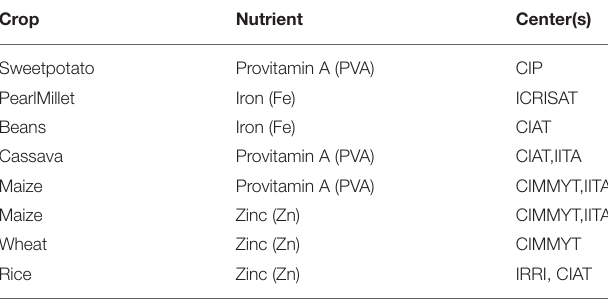
TABLE 1 | Prioritization of crop-nutrient combinations and Consultative Group on International Agricultural Research (CGIAR) centers involved in targeted